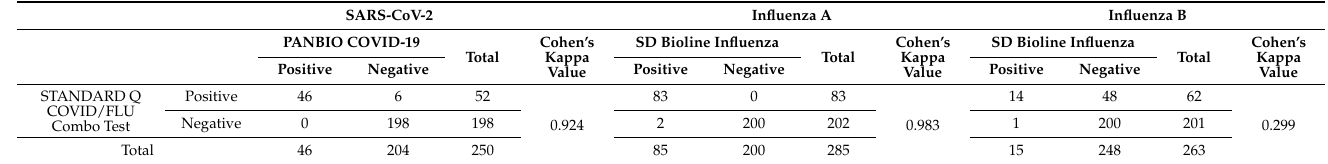
Table 5. Agreement of the STANDARD Q COVID/FLU Ag Combo with the Panbio COVID-19 test kit for detection of SARS-CoV-2, and SD Bioline Ultra Rapid test kit for influenza A and influenza